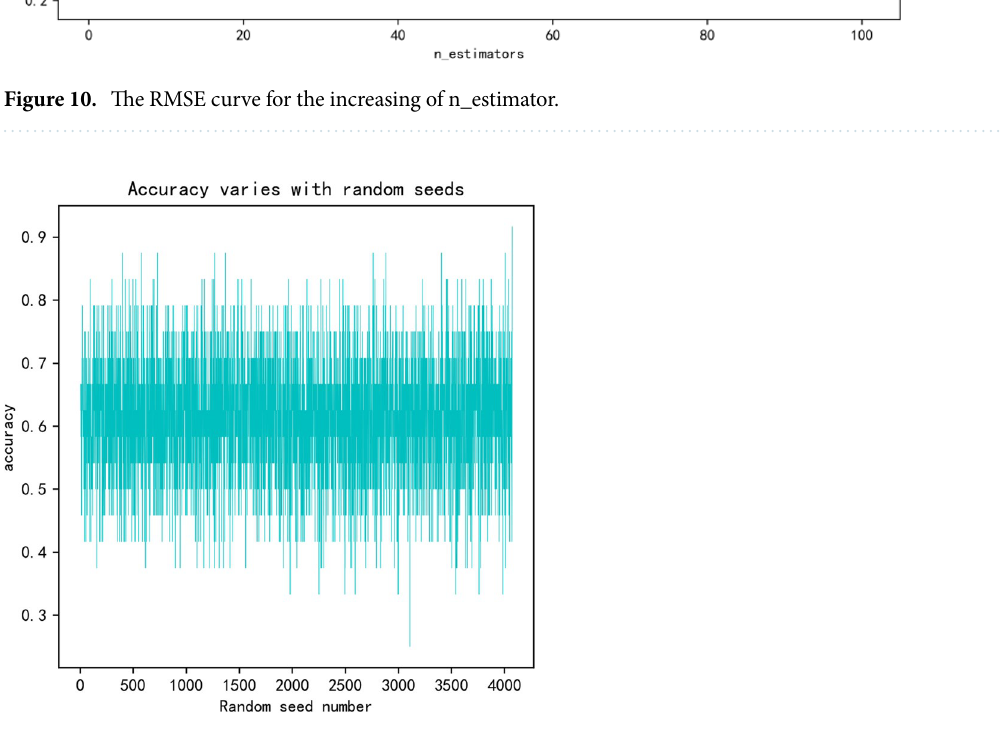
Figure 11. The change of accuracy with different random seed